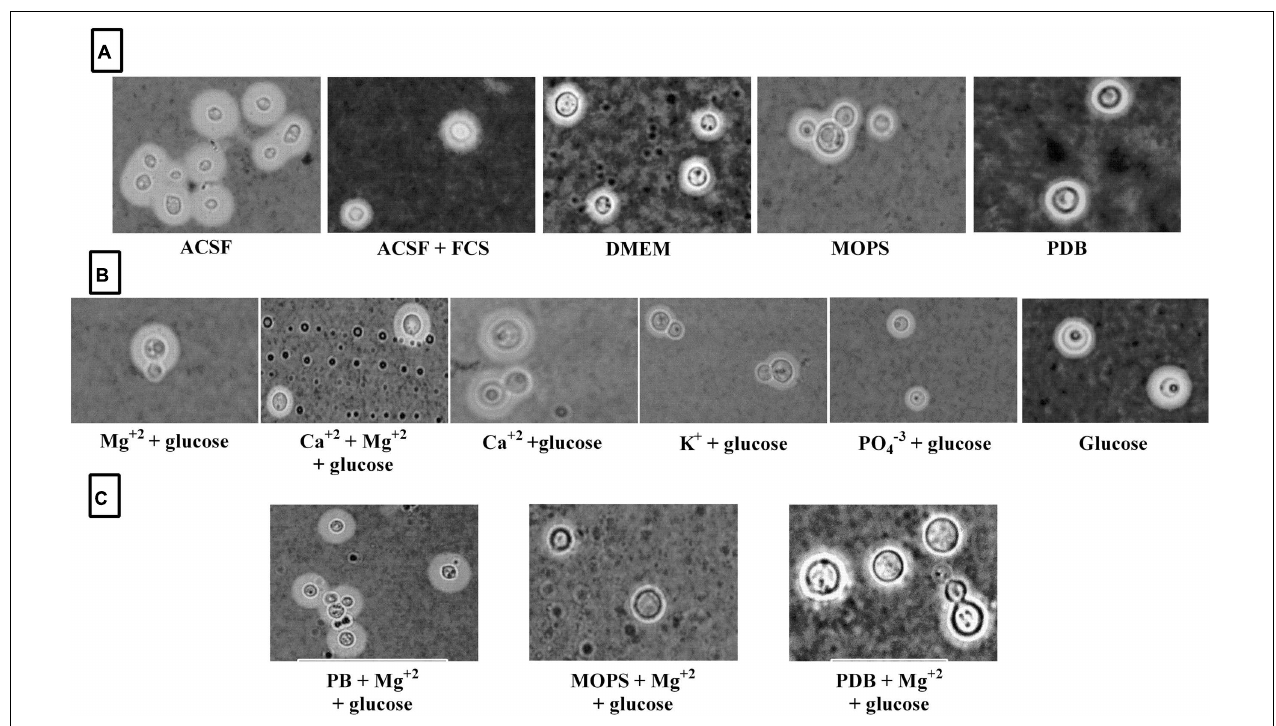
FIGURE 7 | ATCC C. neoformans capsule induction in different media. (A) Capsule induction in different media; (B) Capsule induction in individual ACSF salts; (C) Capsule induction in different media supplemented with Mg 2 + ion.